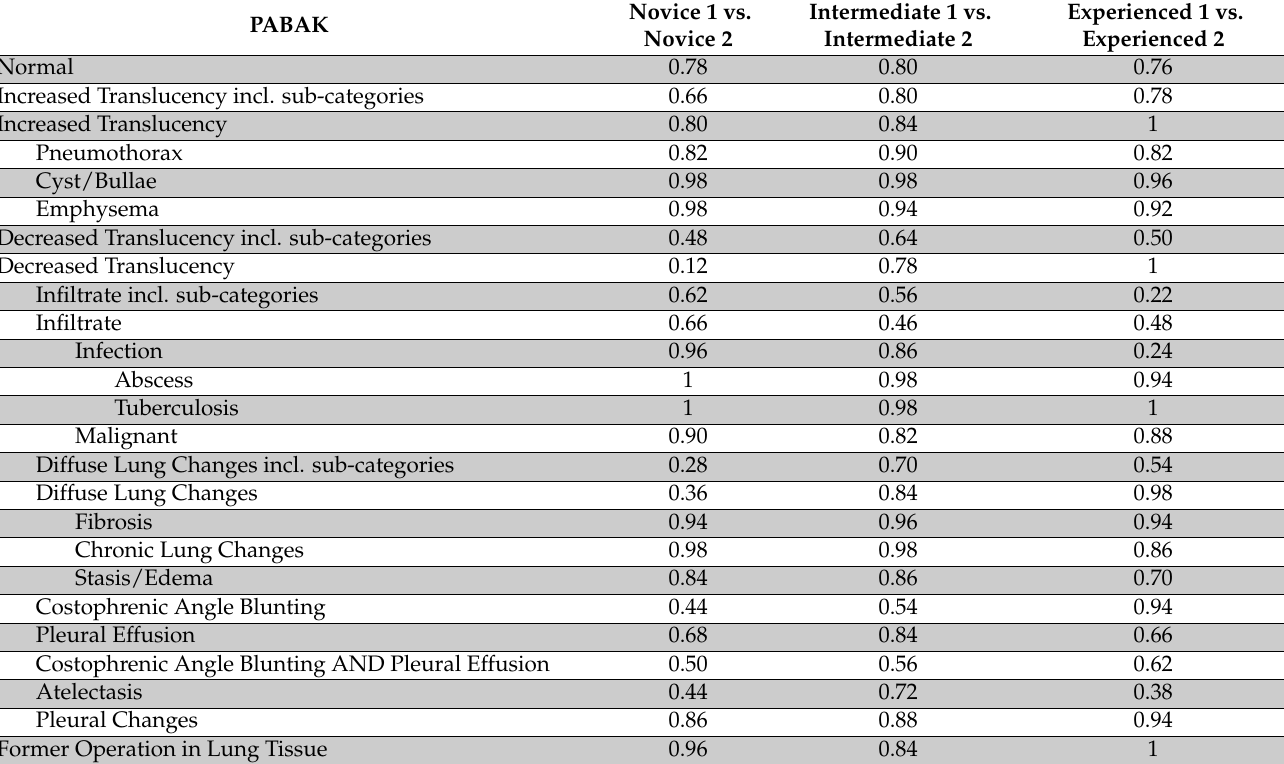
Table A1. Prevalence- and bfias-adjusted Kappa (PABAK) for novice, intermediate, and